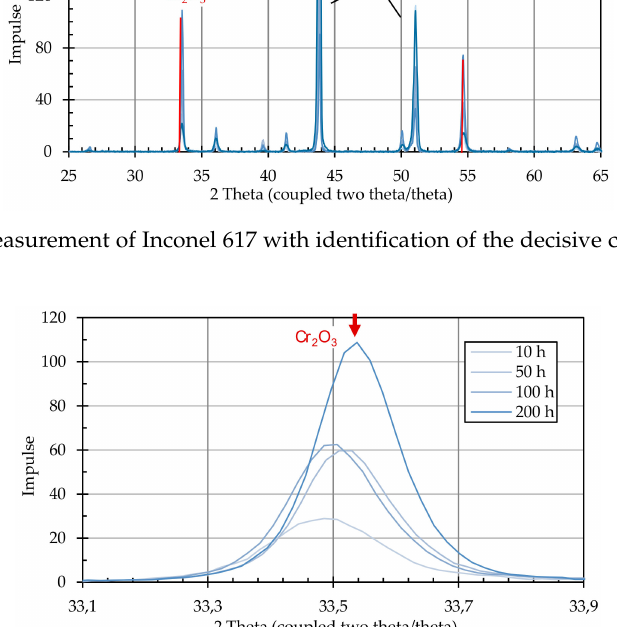
Figure 16. XRD measurement of Inconel 617 with enlarged representation of the decisive connections.